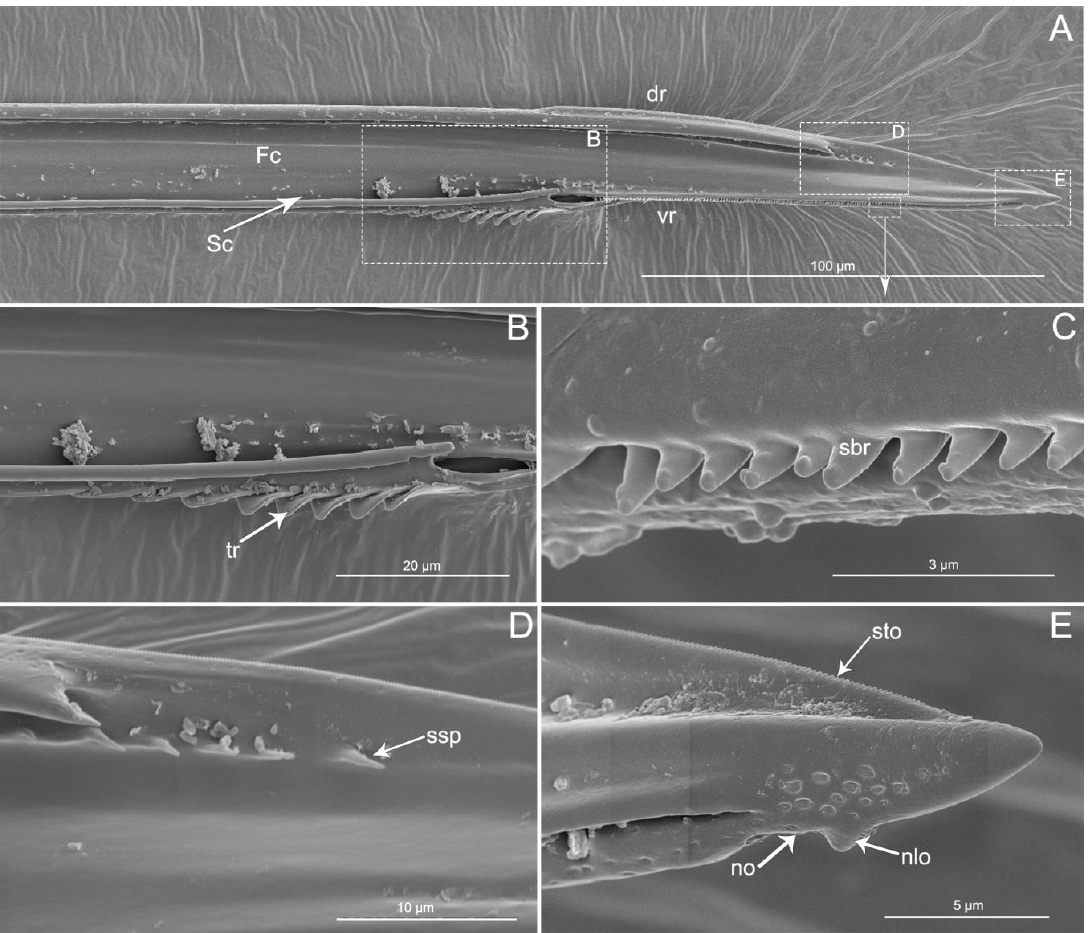
Figure 9. SEM of left maxillary stylets of Haematoloecha nigrorufa . ( A ). Interior view; ( B – E ). Enlarged view of box in ( A ); tr, transverse ridges; sbr, short bristles; no, notch; nlo, narrow lobe; sto, small tooth; ssp, short spines.